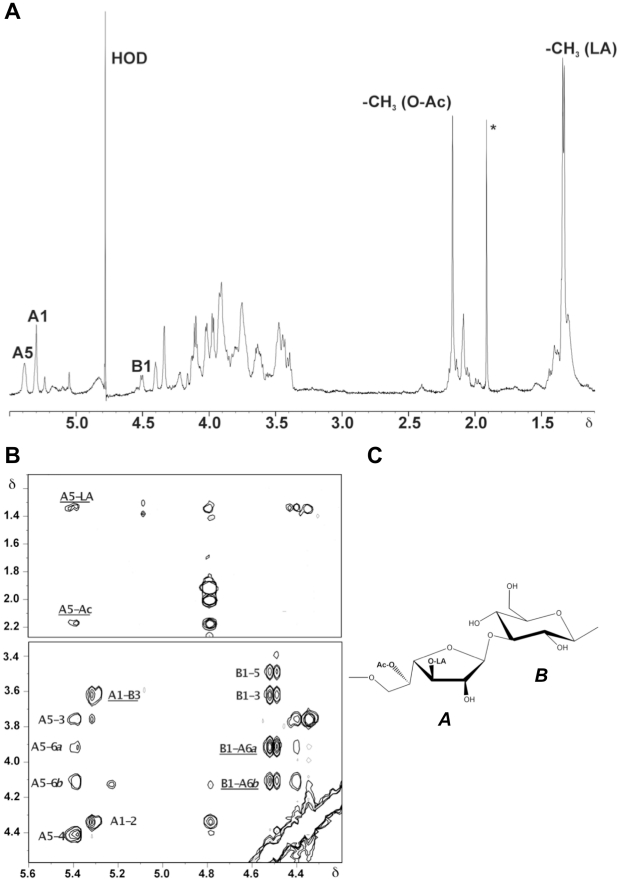
Structural characterization of diheterglycan by nuclear magnetic
resonance (NMR) analysis.(A) The 1H NMR spectrum of diheteroglycan
isolated from E. faecalis type 2. The spectrum was
recorded at 600 MHz and 27°C. The letters refer to
the carbohydrate residues as shown in chemical structure (Fig. 2C), and the
numbers refer to the protons in the respective
residues; LA, lactic acid. (B) Sections of the ROESY
spectrum of E. faecalis diheteroglycan. The
interresidual NOE contacts are underlined.
(C) Chemical structure of the repeating unit of
E. faecalis capsular diheteroglycan. * Acetic
acid remain of the final gel-permeation chromatography step.